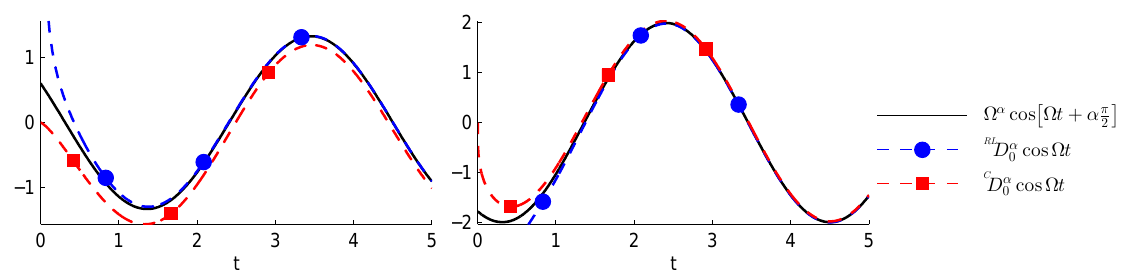
(cid:0) Ω (cid:1) t + α π for Ω = 1.5, α = 0.7 2